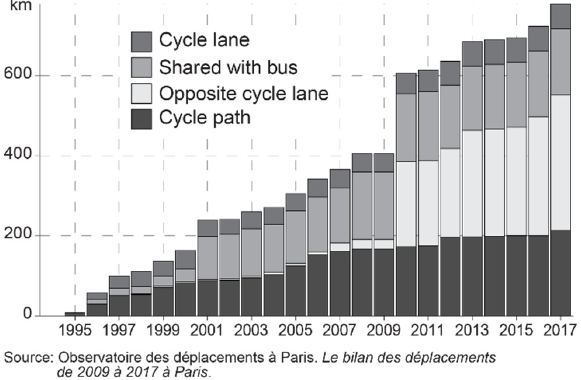
Figure 1. The development of a cycling network in Paris between 1995 and 2017.